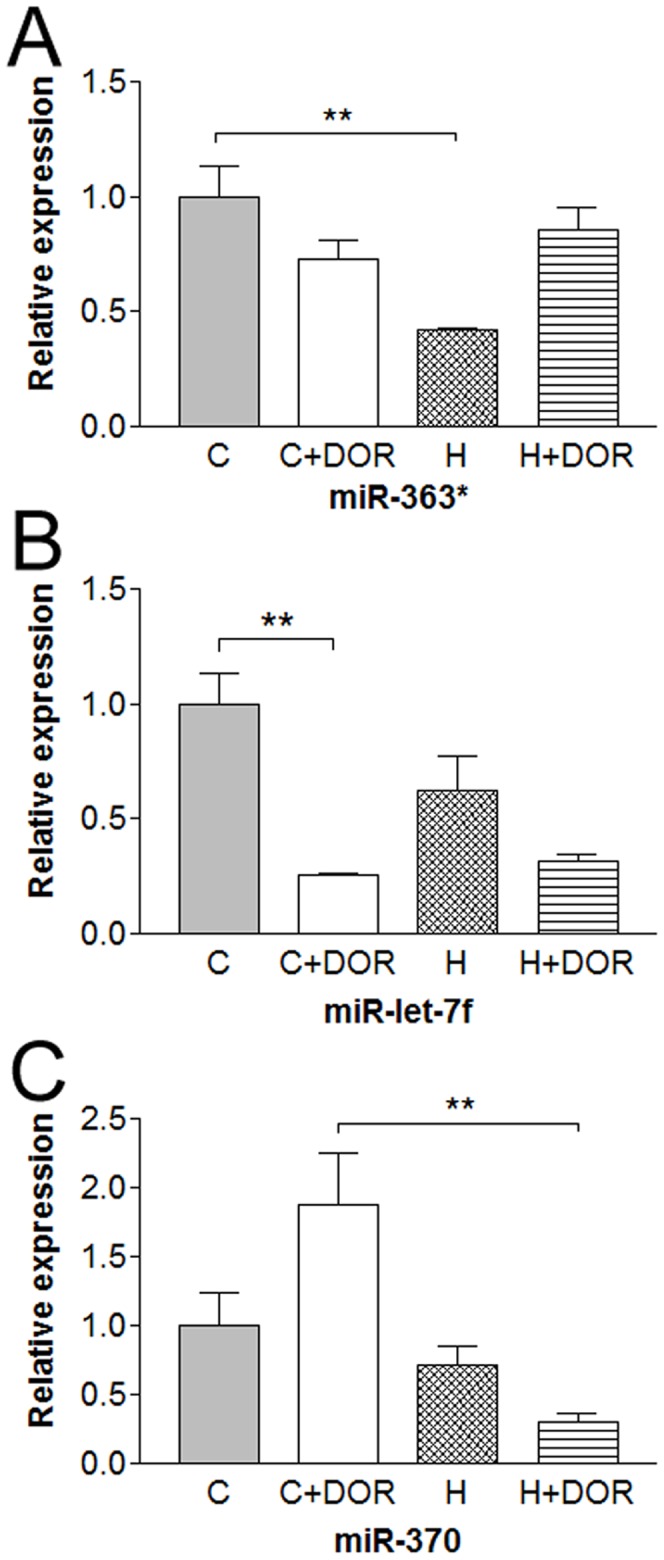
Relative miRNA expression levels of miR-363*, miR-let-7f, and miR-370 in the kidney following 10 days of hypoxia as determined by quantitative RT-PCR.C, control; C+DOR, control+UFP-512; H, hypoxia; H+DOR, hypoxia+UFP-512. **p<0.01.